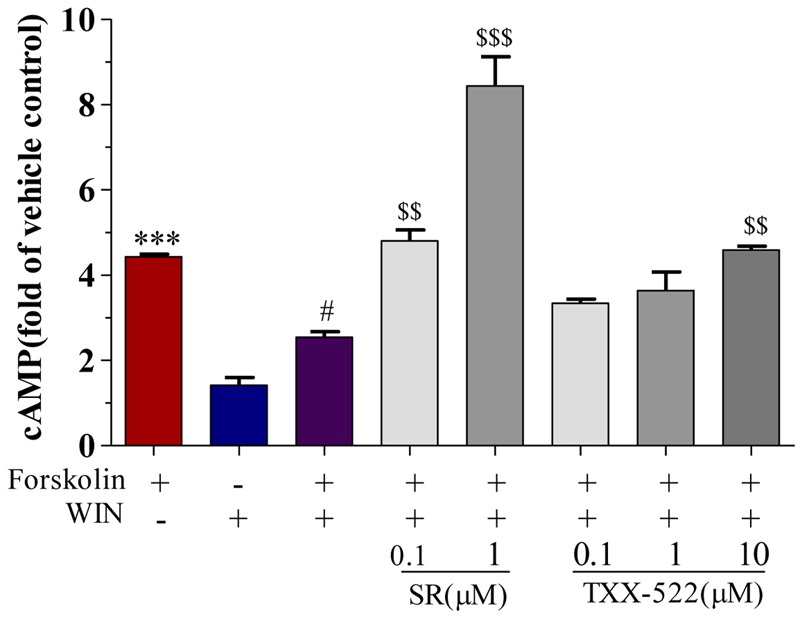
Effect of TXX-522 on WIN 55,212-2-mediated inhibition of forskolin-induced cAMP accumulation in CHO cells expressing human cannabinoid receptor 1 (CB1R). Data are expressed relative to cAMP level in control cells. Cells were exposed to 0.1 μmol/L forskolin. WIN, WIN 55,212-2 (1 μmol/L); SR, SR141716A. Data are means ± SEM, ∗∗∗P < 0.001 vs. vehicle control cells; #P < 0.05 vs. forskolin-treated cells; $$P < 0.01, $$$P < 0.001 vs. forskolin plus WIN-treated cells.